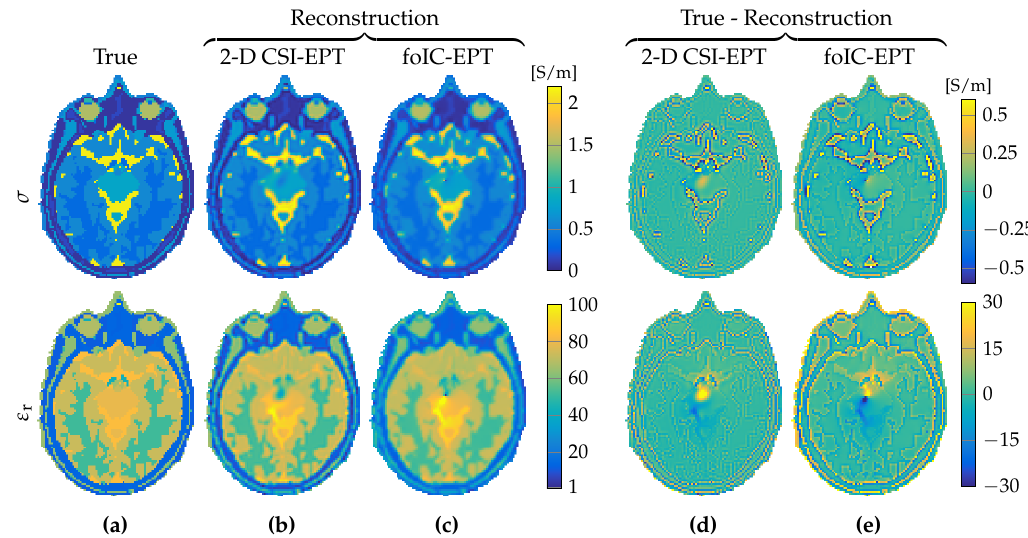
Figure 2. Reconstruction results from 2D reconstruction methods. ( a ) True model, ( b ) reconstruction obtained after 5000 iterations of 2D CSI–EPT, and ( c ) reconstruction from foIC-EPT. Respective errors are shown in ( d , e ). Top row shows conductivity and bottom row shows relative permittivity.